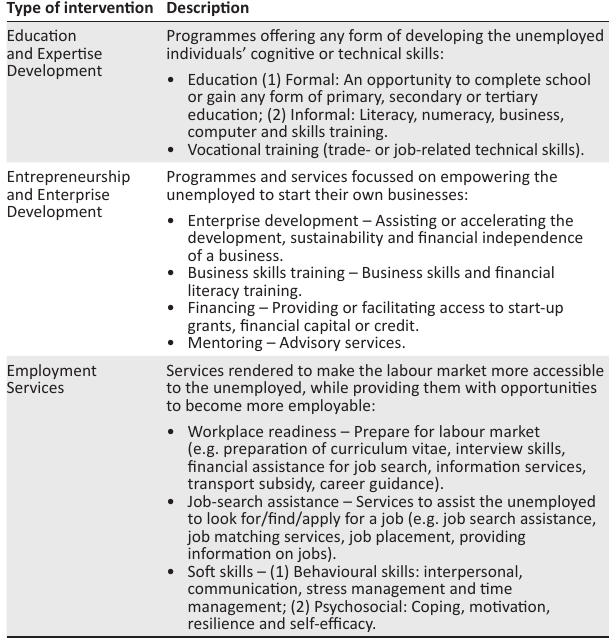
TABLE 1: Framework for classifying types of